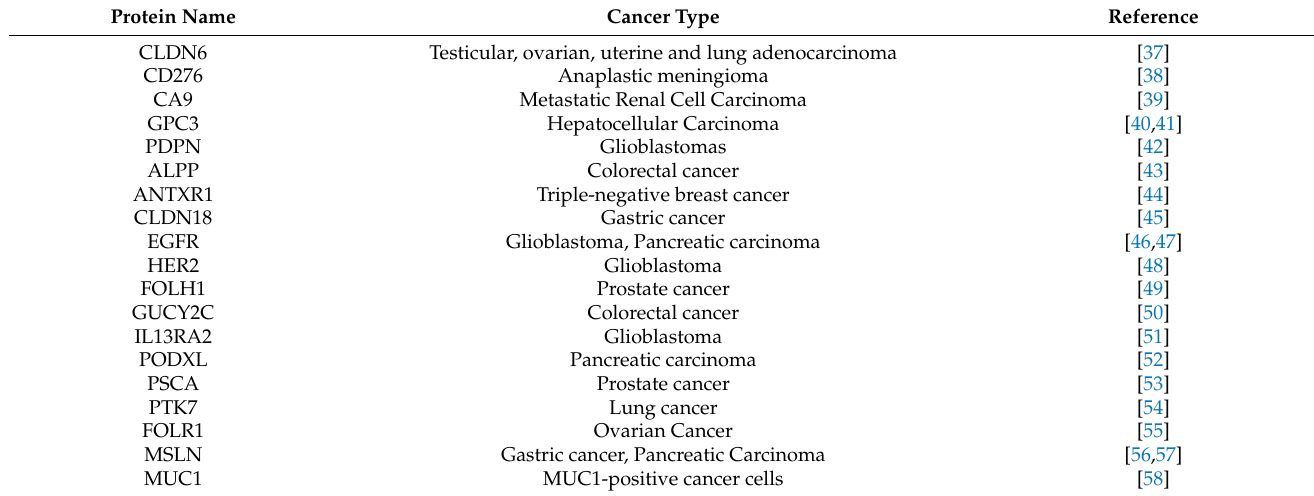
Table 3. Targets that have been reported for CAR-T therapy in solid tumors.